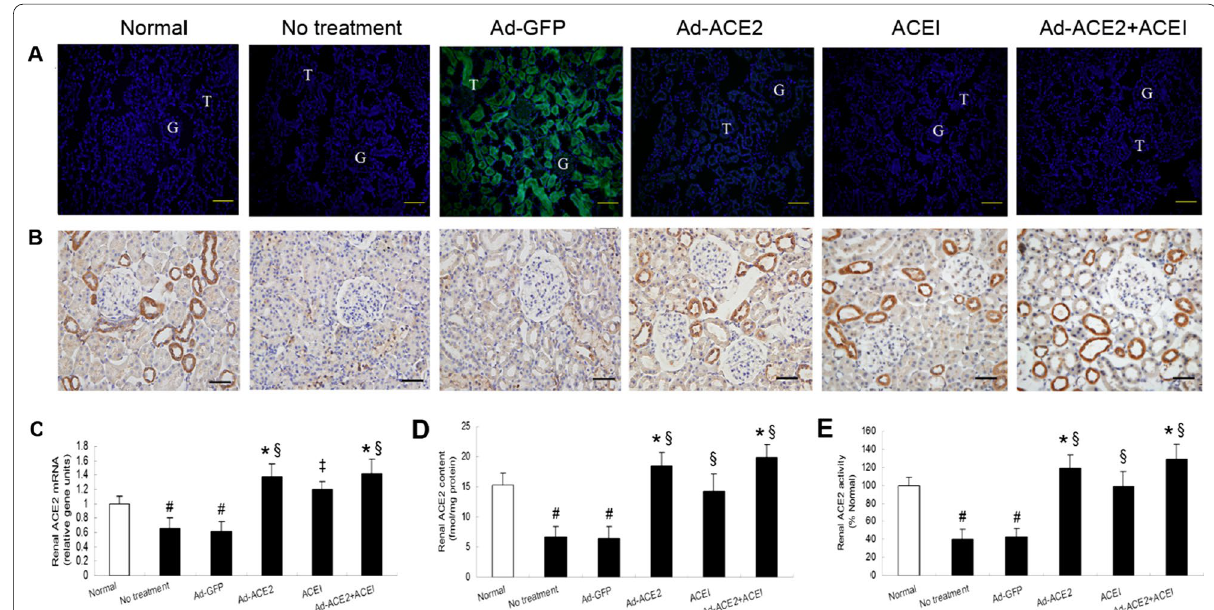
Fig. 1 Efficiency of gene transfer 4 wks after gene delivery. A Fluorescence microscopic images of frozen sections of the kidneys in the normal, no treatment, Ad-GFP, Ad-ACE2, ACE1 and Ad-ACE2 ACEI groups, respectively (bar 50 μm). G indicates glomeruli and T indicates tubules. B + = Immunochemical staining showing the localization of ACE2 protein in cortical sections from each group. Weak ACE2 staining was observed in tubules from rats in the no treatment and Ad-GFP groups, whereas marked ACE2 staining was depicted in both tubules and glomeruli from rats in the normal, Ad-ACE2, ACEI and Ad-ACE2 ACEI groups (bar 50 μm). C, D, E Quantitative analysis of ACE2 mRNA levels, protein levels and + = activities. *P < 0.05, # P < 0.01 versus normal group; ‡ P < 0.05, § P < 0.01 versus no treatment